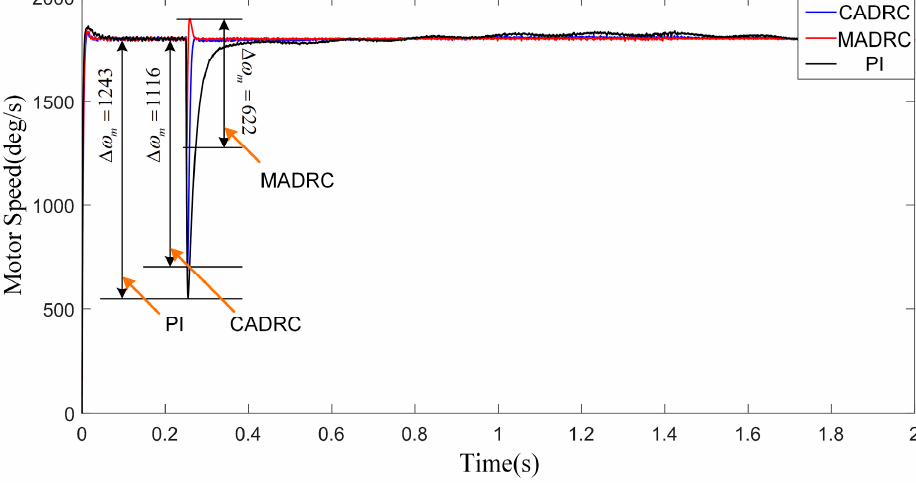
Figure 8. The ESO estimated unknown disturbance of CADRC and MADRC in the speed loop. 0